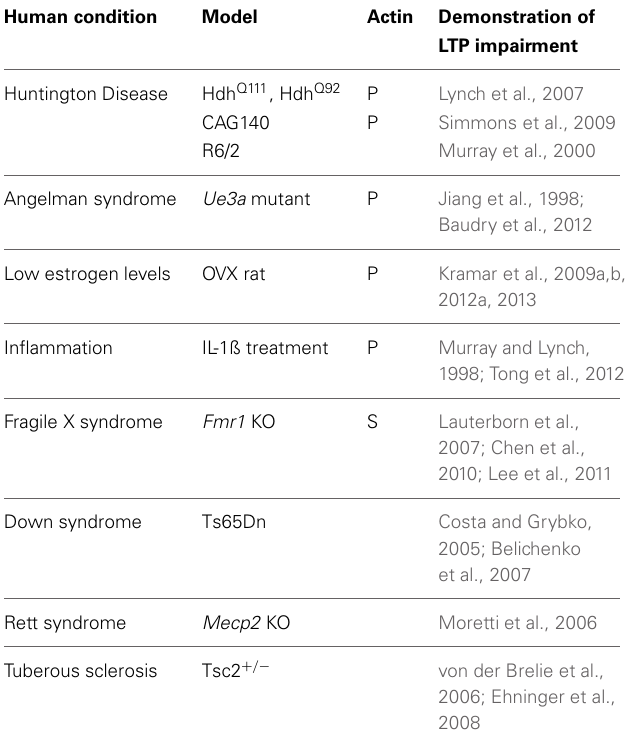
Table 1 | Models of human intellectual disability have deficits in LTP and spine actin management.